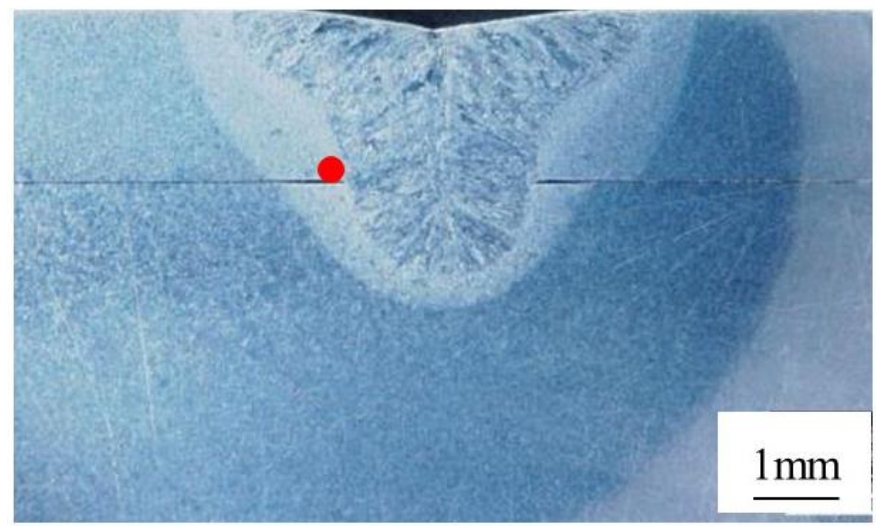
Figure 2. Cross-section metallographic image after the experiment. Table 1. Chemical composition of PNC-FMS (target composition).